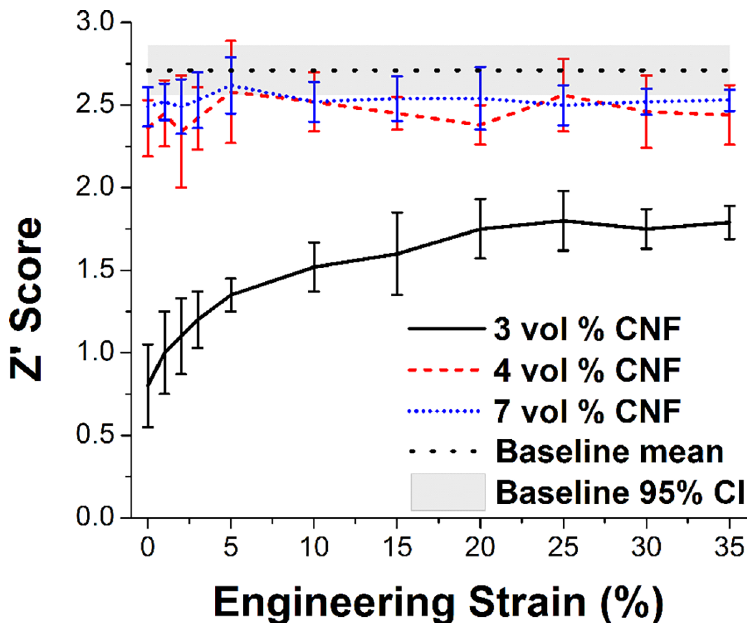
Fig 5. Correlation (Z’ transformed R) between recorded signals and a baseline direct connection pass-through record for filler loadings of 3, 4, and 7 vol % with increasing comrpessive strain. Horizontal dashed line represents ideal expected performance based on correlation to other pass-through records.